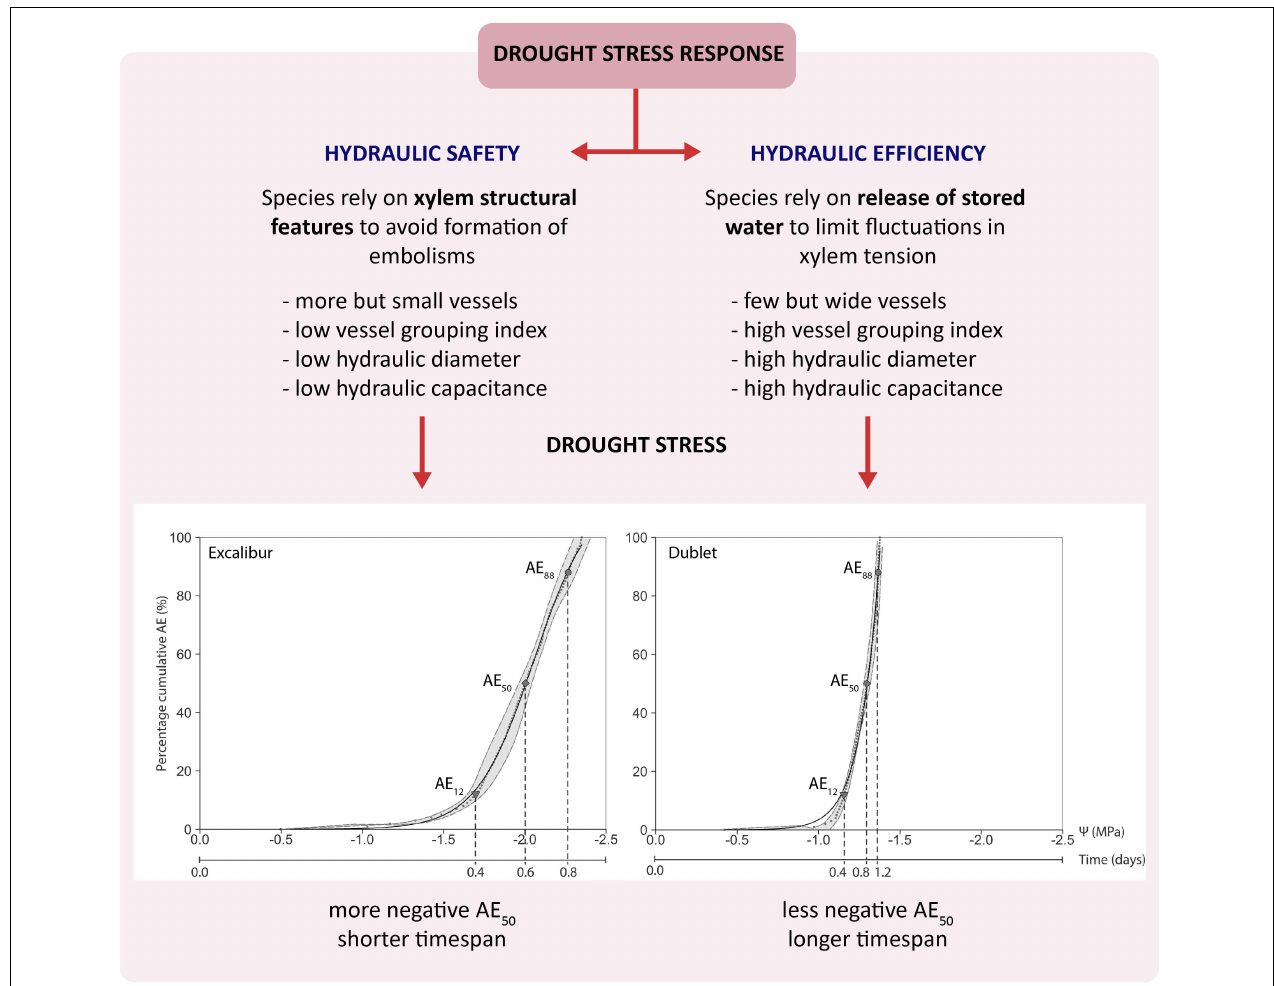
FIGURE 5 | Schematic figure showing the contrasting response of studied cereals to drought stress.